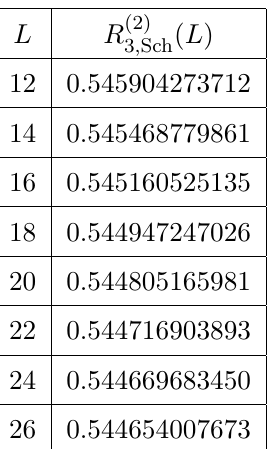
Table 14 . The rational function R (2)